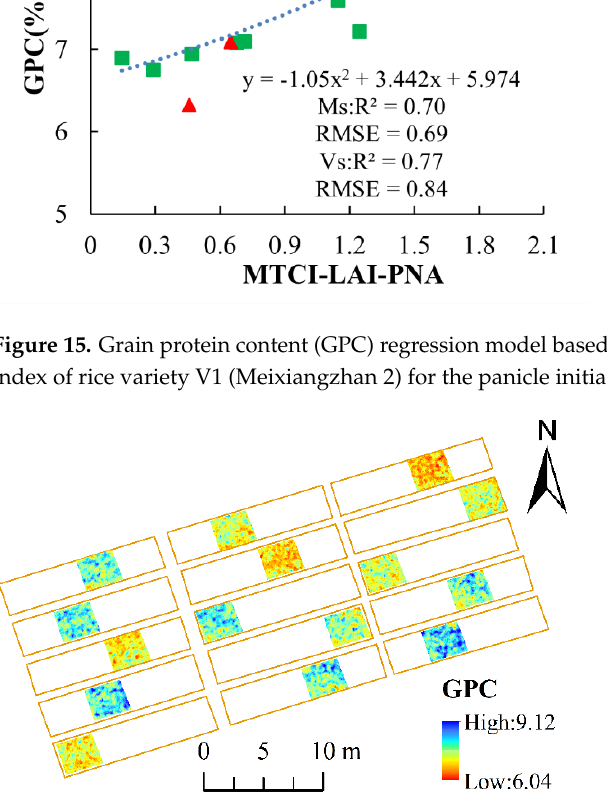
Figure 16. Grain protein content (GPC) map of rice variety V1 (Meixiangzhan 2) in 2019 based on the 2020 three-dimensional monitoring index model.